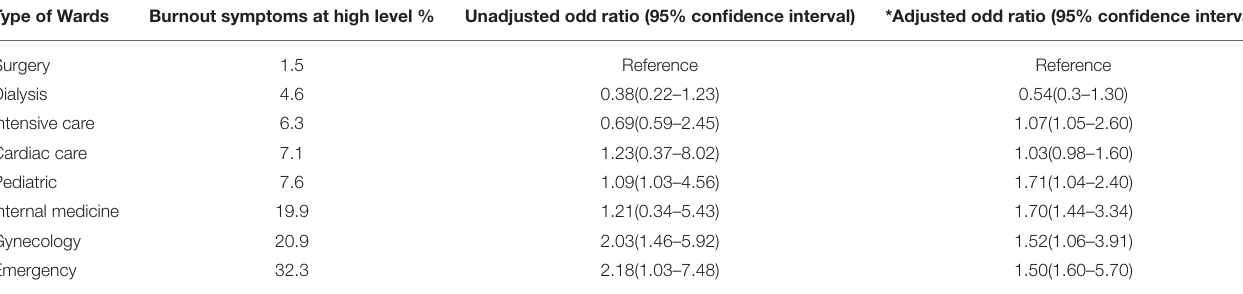
TABLE 3 | Association of working in hospital wards with high level of burnout symptoms in studied